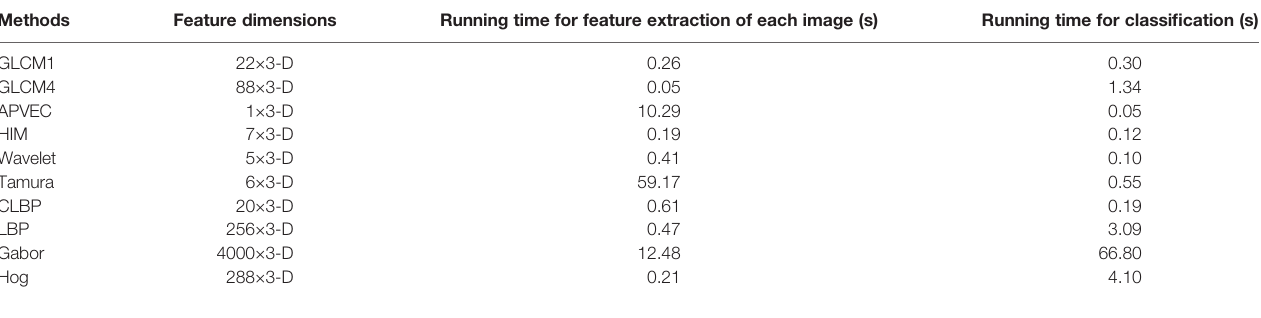
TABLE 4 | Running time for feature extraction of each image and classi fi cation of different descriptors. Methods